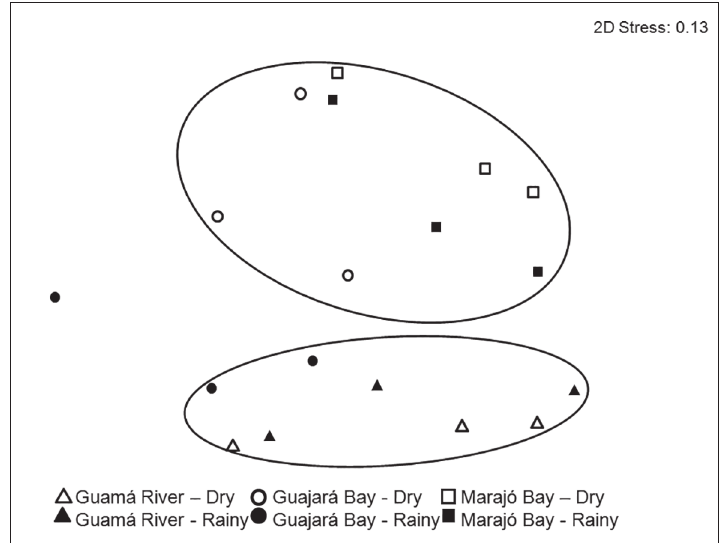
Figure 4 - Multivariate multidimensional scaling analysis by environment guild by zone (Guamá River, Guajará Bay and Marajó Bay) and season (Dry and Rainy season), Amazon Estuary, northern Brazil.